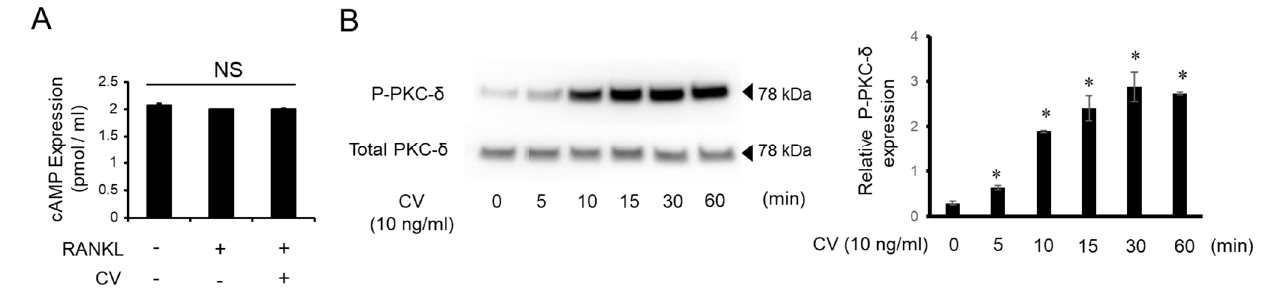
Figure 3. CV upregulates phosphorylation of PKC- δ in RANKL-stimulated OCs. ( A ) Amount of cAMP at 12 h after stimulation of CV (10 ng/mL). Results are shown as means ± SD. ( B ) Western blotting was performed on protein extracts from OC precursors stimulated with CV (10 ng/mL) for 0, 5, 10, 15, 30 and 60 min. Total amount of PKC- δ and p-PKC- δ was evaluated using the antibodies described in the Materials and Methods section. Densitometric analysis of p-PKC- δ signals is shown. The relative level of p-PKC- δ expression was normalized to total PKC- δ expression. All assays were performed in triplicate and the results were expressed as the mean ± SD. One representative picture band out of three experiments is shown. * p < 0.05.